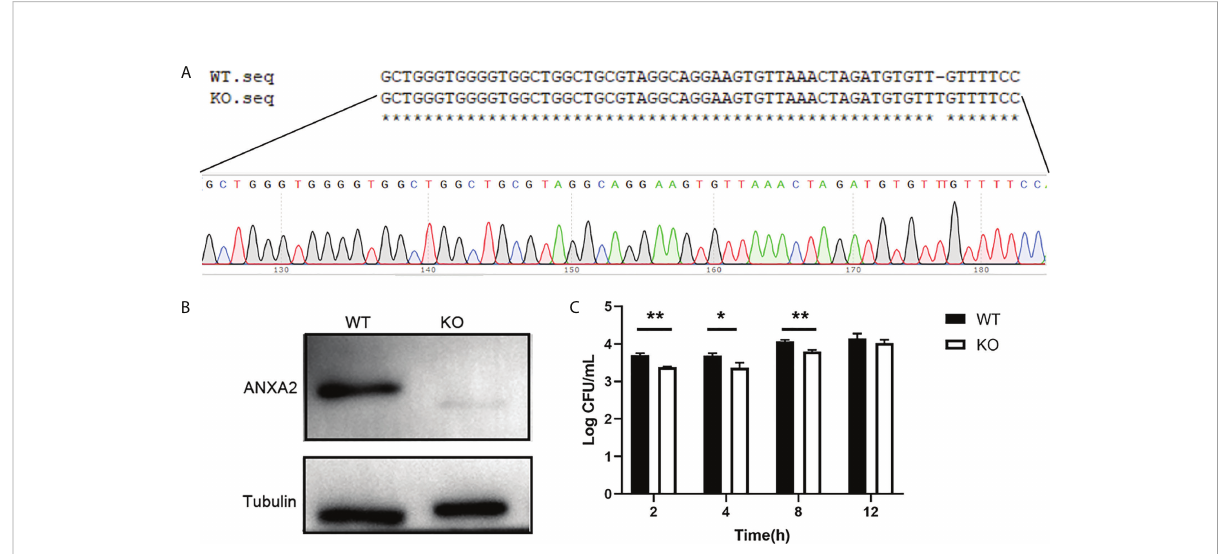
FIGURE 4 Generation of ANXA2-KO EBL cells by using CRISPR/Cas9 system. (A) BLAST analysis of sequences around the PAM sequence of WT EBL and ANXA2-KO EBL cell lines. (B) ANXA2 knockout was con fi rmed by western blotting with an anti-ANXA2 mouse antibody. (C) The invasion ability of M. bovis in ANXA2-KO EBL cells. ANXA2-KO EBL cells (KO) or wild-type EBL cells (WT) were infected with M. bovis at an MOI of 1000. The intracellular bacteria were determined using gentamicin invasion assay (mean ± S.D., * p <0.05, ** p